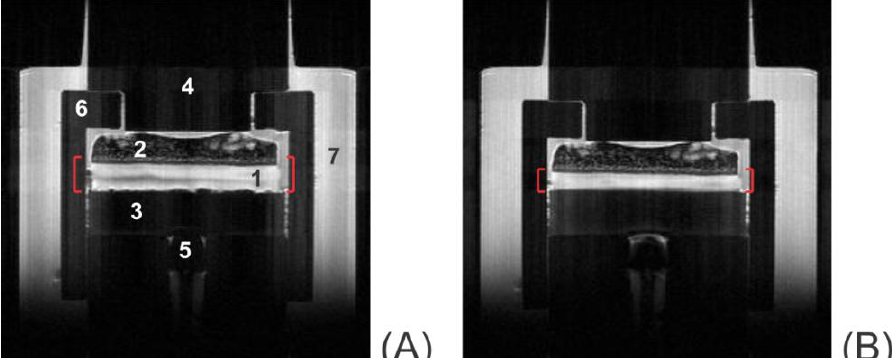
Figure 7. Representative T -weighted images of bone-cartilage plugs: ( A ) uncompressed 2 Sample 4 and ( B ) Sample 4 compressed under the applied pressure of 110 kPa. Both images were taken at the echo time of 7.375 ms. Labeled with the numerals